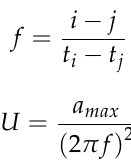
Figure 5. An example of crack dimension measurement by DinoCapture 2.0.